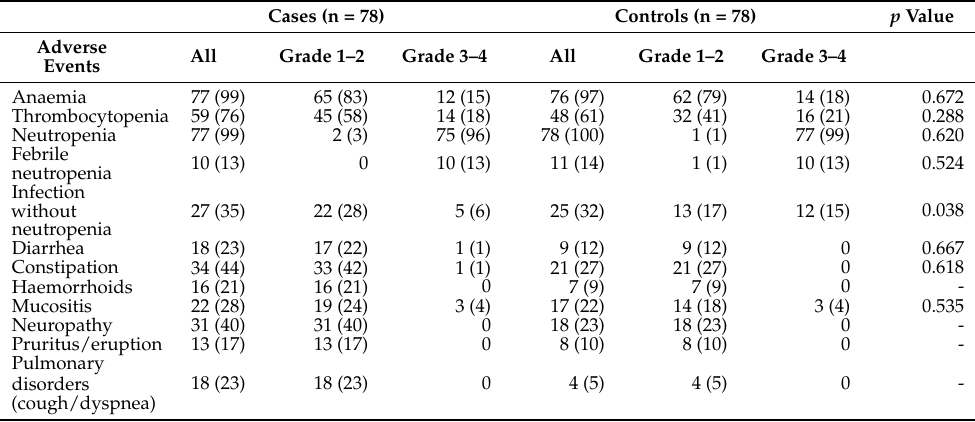
Table 4. Treatment adverse